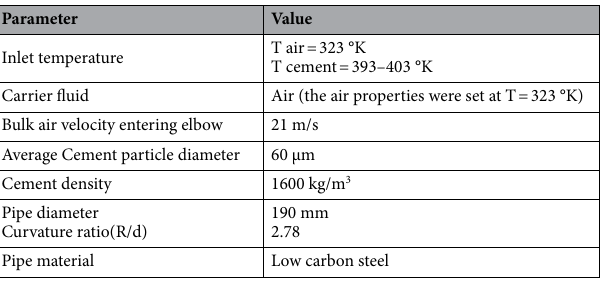
Table 2. Initial boundary conditions of flow inside elbow and pipe 20 .